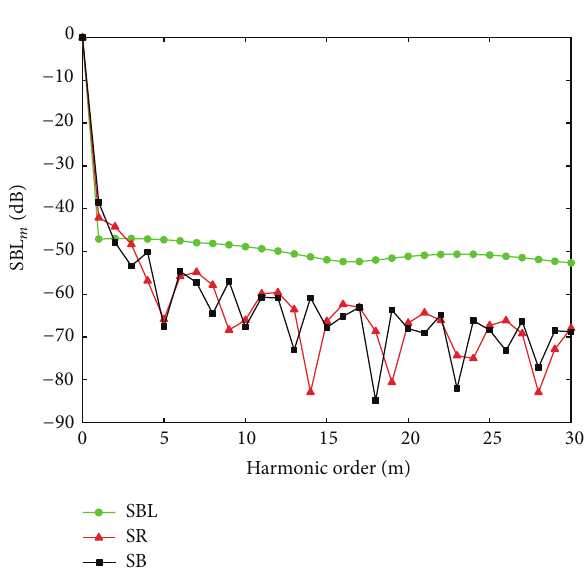
Figure 14: The first 30 maximum harmonic levels of best converged solution related to Figure 12 for SC.